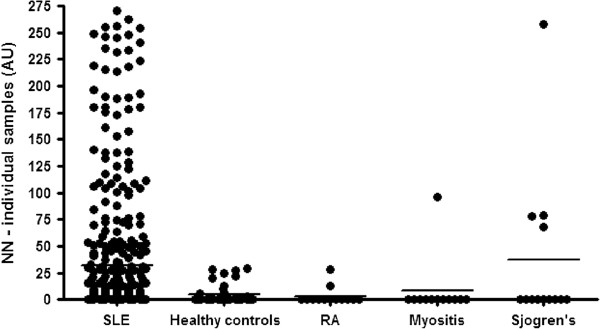
NN levels in patients with SLE compared to healthy and autoimmune disease controls. This figure shows the results obtained in the NN ELISA on testing serum samples from patients with SLE in comparison with healthy controls and patients with other autoimmune rheumatic diseases (myositis, rheumatoid arthritis and Sjogren’s syndrome). NN levels were higher in the SLE group than the other groups (P = 0.01 by one way ANOVA/Kruskal Wallis test). NN, nitrated nucleosomes; SLE, systemic lupus erythematosus.